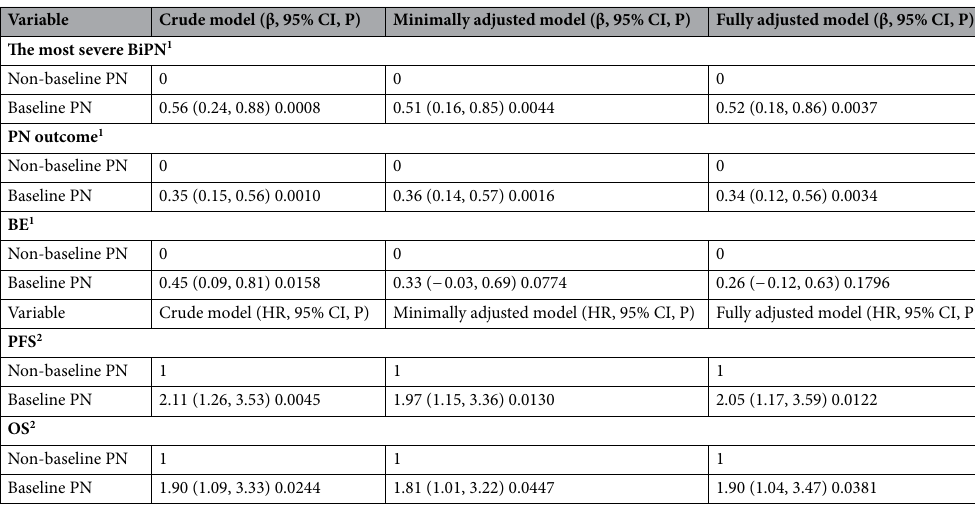
Table 3. Mutiple regressions analysis between the most severe BiPN/PN outcome/BE/PFS/OS and the baseline PN. Crude model adjust for: None. Minimally adjusted model adjust for: gender, immunoglobin type, light chain type. Fully adjusted model adjust for: age, gender, immunoglobin type, light chain type, DS stage, Creatinine, β2 microglobulin; lactate dehydrogenase; bortezomib dose and administration route. β regression coefficient, PN peripheral neuropathy, BiPN bortezomib induced PN, BE the best efficacy during the inductive therapy, PFS Progression-free survival, OS overall survival. Statistical methods: 1 variable-adjusted multiple linear regression; 2 variable-adjusted COX proportional hazards